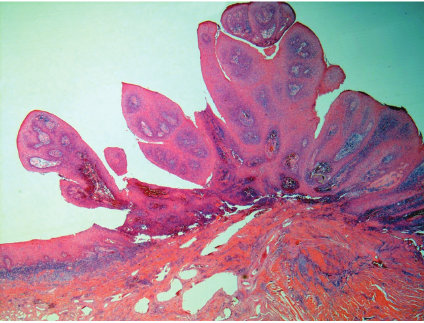
Figure 2: Photomicrograph of verrucous hyperplasia showing blunt surface projections (original magnification 4x, H and E stain).